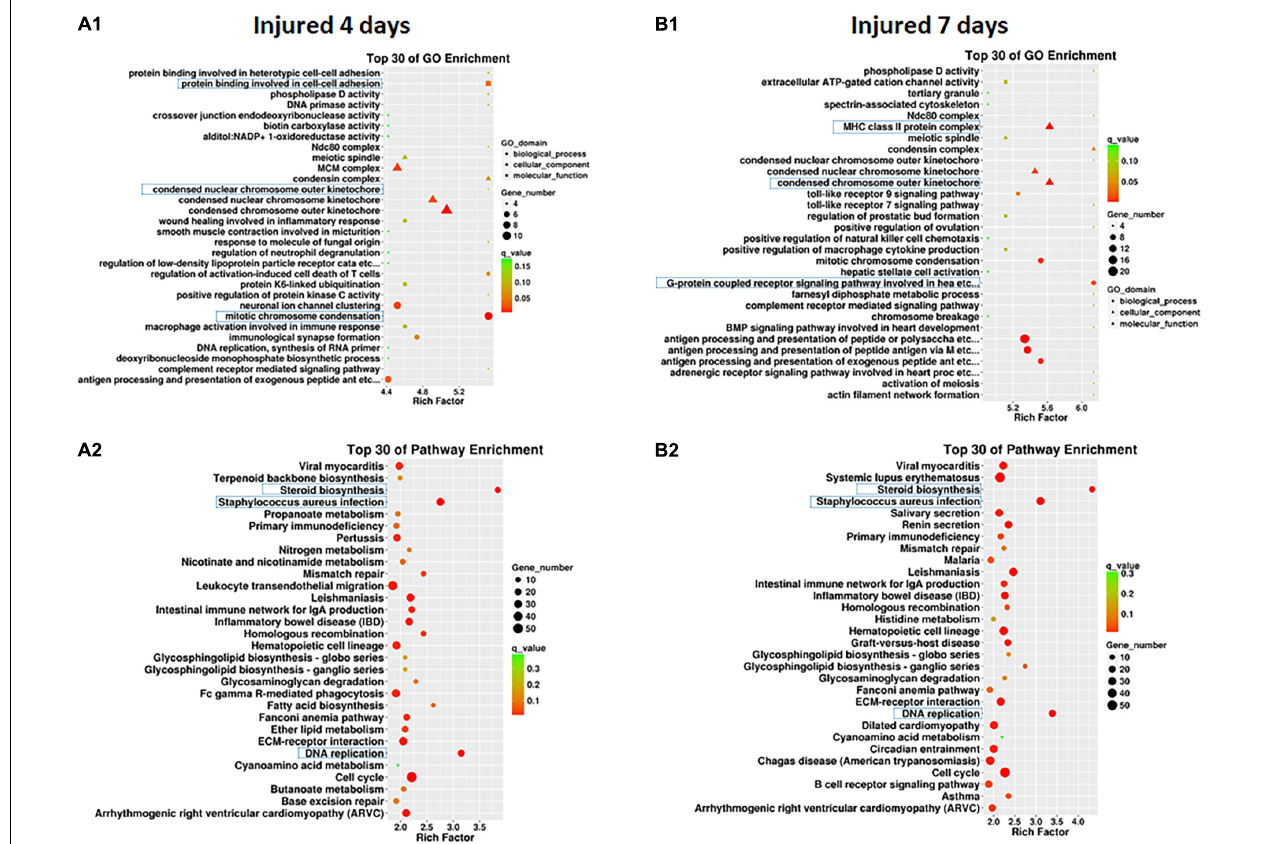
FIGURE 4 | GO enrichment map (A1,B1) and KEGG pathway enrichment map (A2,B2) of differentially expressed mRNAs in SD rats 4 and 7 days after sciatic nerve injury compared with rats without injury during the early stage after sciatic nerve contusion. (A1) GO gene enrichment map at 4 days after injury; (B1) GO gene enrichment map at 7 days after injury. The different shapes in the figure represent different categories, with circles representing biological processes, triangles representing cellular components, and squares representing molecular functions. A larger shape area indicates a greater number of DEmRNAs in that category. The significant differences in the distribution of DEmRNAs in different subcategories between the two groups are indicated by different colors, where green indicates q -values > 0.15, yellow indicates that q -values are between 0.10 and 0.15, orange indicates that q -values are between 0.05 and 0.10, and red indicates q -values < 0.05. The test criterion was set at 0.05. (A2) KEGG gene enrichment map at 4 days after injury; (B2) KEGG gene enrichment map at 7 days after injury. A larger graphical area in the figure indicates a higher number of DEmRNAs in that channel. The significant differences in the distribution of DEmRNAs in different channels between the two groups are indicated by different colors, where green indicates q -values > 0.3, yellow indicates that q -values are between 0.2 and 0.3, orange indicates that q -values are between 0.1 and 0.2, and red indicates q -values < 0.1. The test criterion was